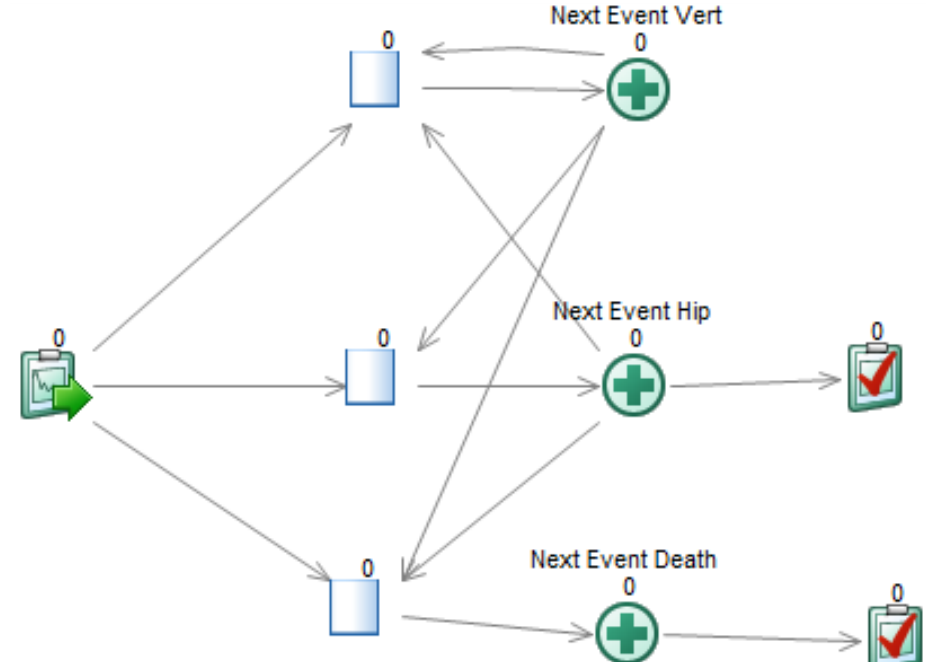
Figure A4. Graph with the simulation flow for the osteoporosis model in